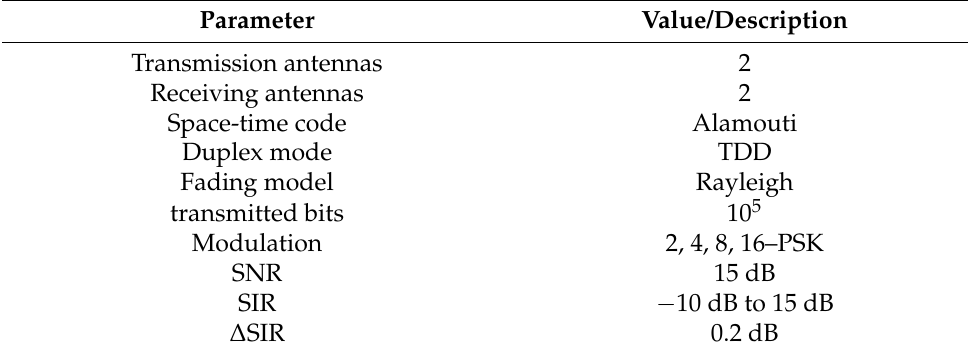
Table 6. Simulations